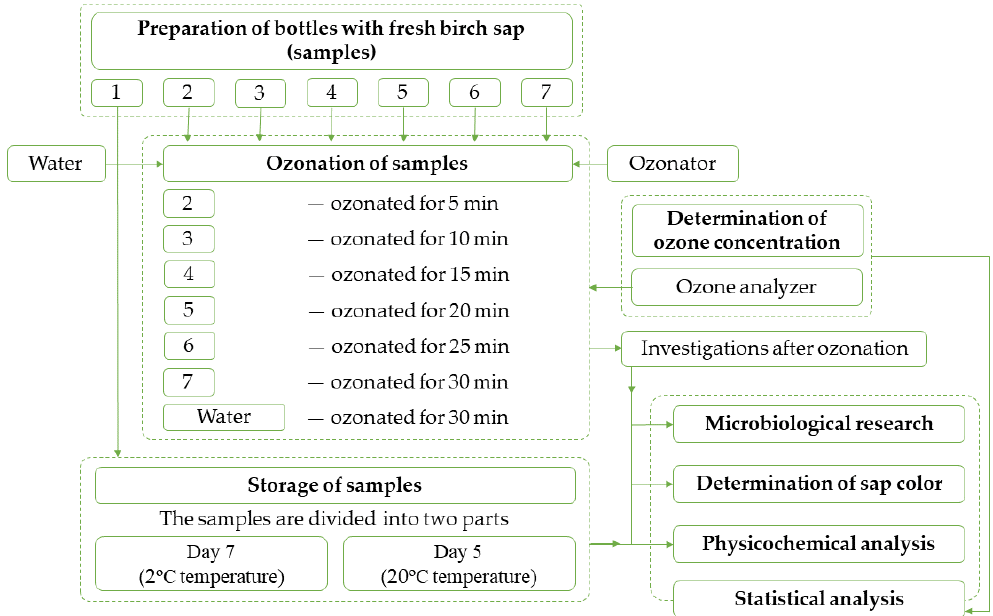
Figure 1. Evaluation of the influence of ozone on the biochemical composition of birch sap. The samples were subdivided as follows: sample 1 (control)—fresh sap (non-ozonated); sample 2—sap ozonated for 5 min; sample 3—sap ozonated for 10 min; sample 4—sap ozonated for 15 min; sample 5—sap ozonated for 20 min; sample 6—sap ozonated for 25 min; sample 7—sap ozonated for 30